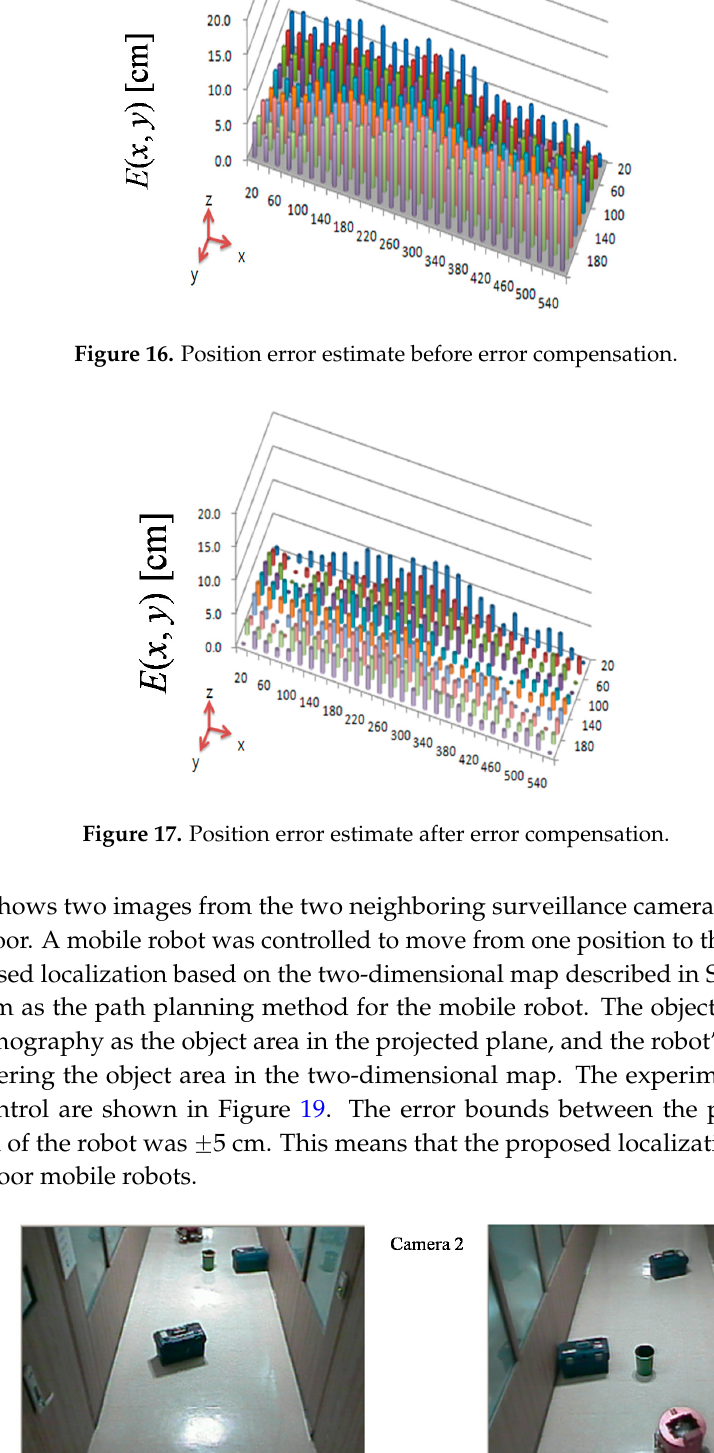
Figure 18. Objects in the experimental environment.